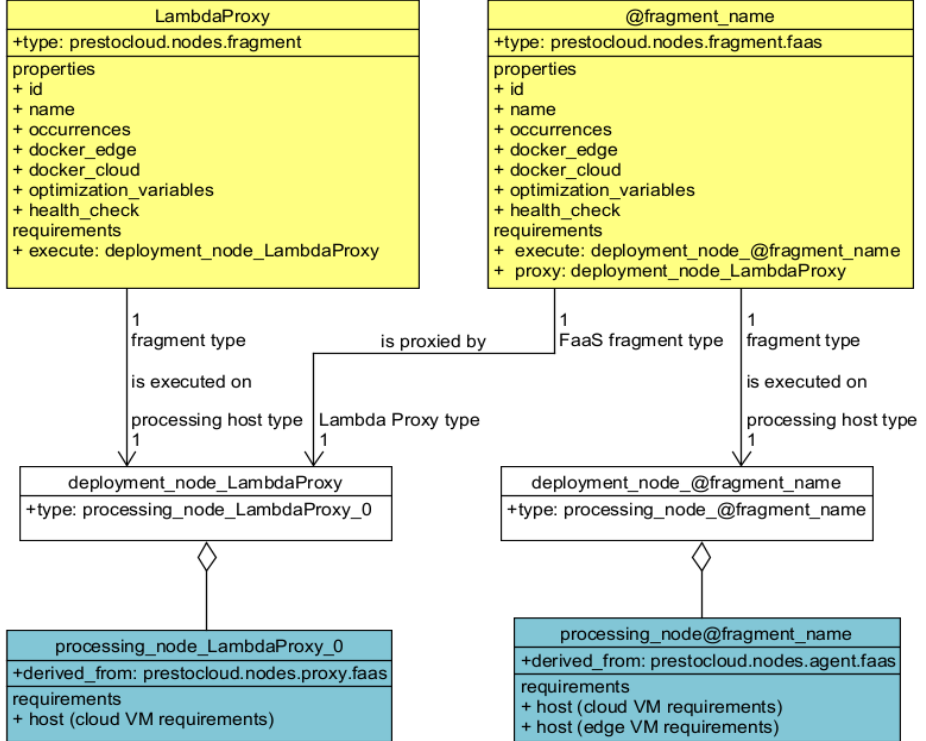
Figure 4. The relationships between the fragment, processing, and mapping nodes of the Lambda Proxy and the proxied FaaS fragments.